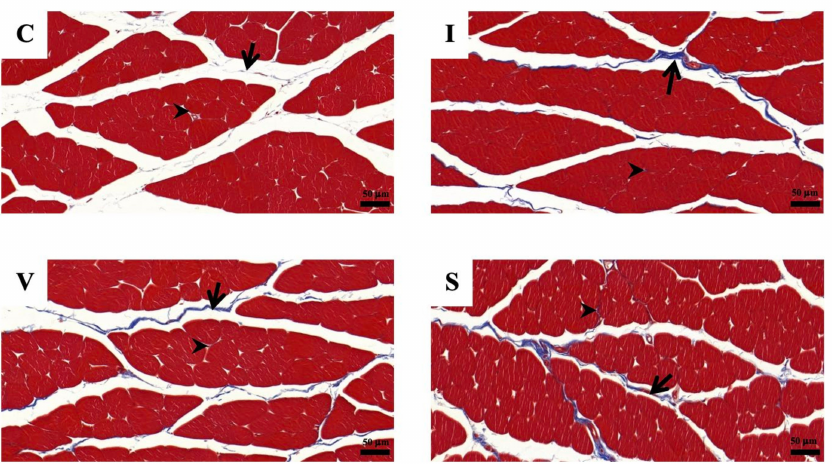
Figure 5. The photomicrographs of Masson’s trichrome staining of quadriceps muscle cross-sections under a light microscope, in Group C ( C ), Group I ( I ), Group V ( V ), and Group S ( S ) on Day 15. ( C ) Control group; ( I ) Cast immobilization group; ( V ) Velcro immobilization group; ( S ) Spiral wire immobilization group. Blue-stained color is collagen, while the red-stained color is muscle fiber. Arrows indicate perimysium, arrowheads indicate endomysium. Magnification at × 200.